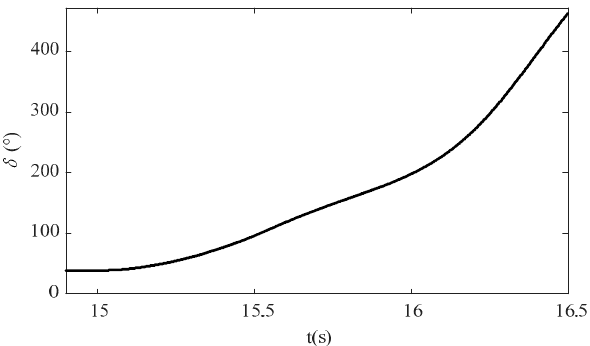
Figure 8. Rotor angle difference between G1 and G2.